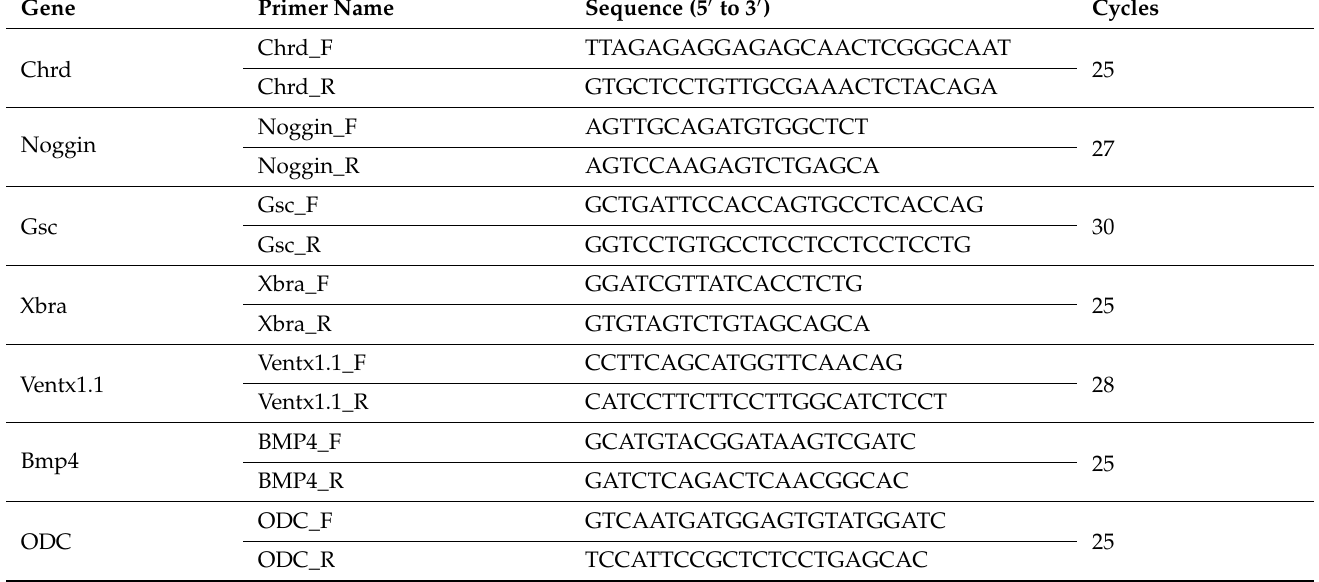
Table 2. Primers used for RT-PCR amplification of several set of